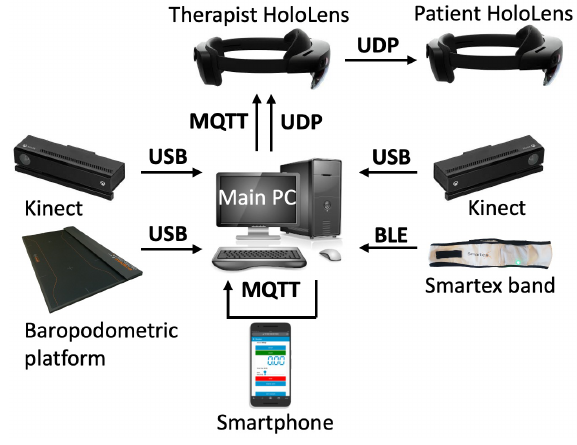
Figure 2. Data transmission